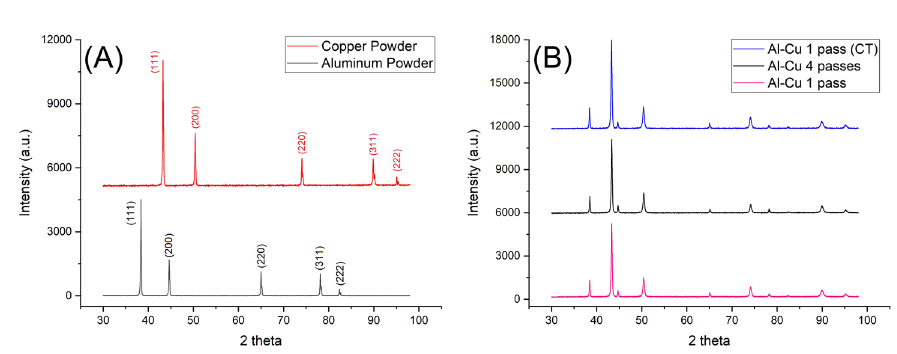
Figure 9. XRD diffractogram for the initial powders of aluminum and copper (A) and for the samples after ECAP (B).